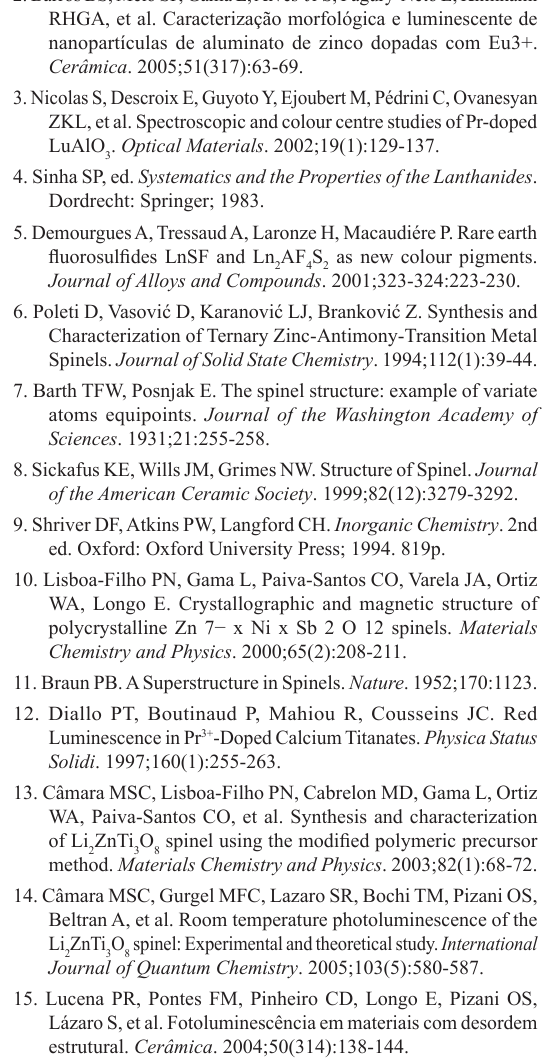
ZnTi O , obtained 2 3 8